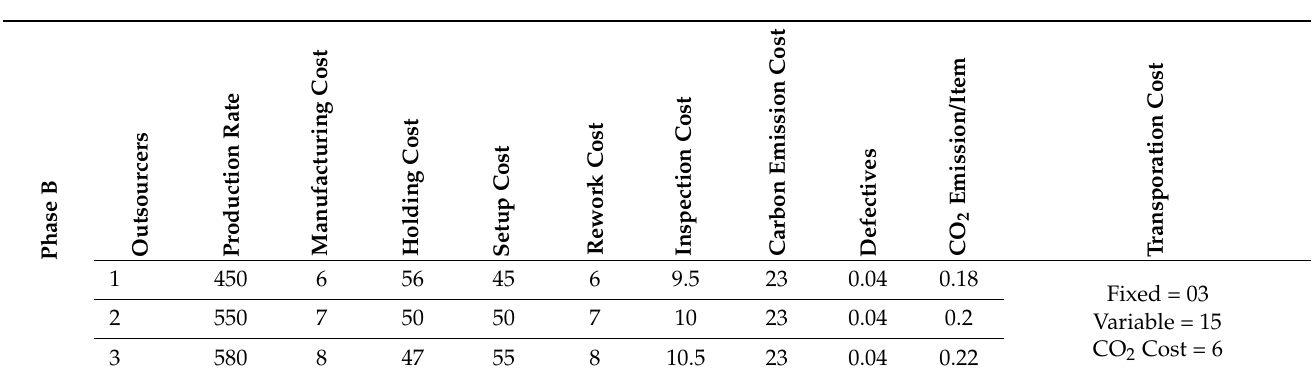
Table 4. Outsourcing data (automobile spare part manufacturing